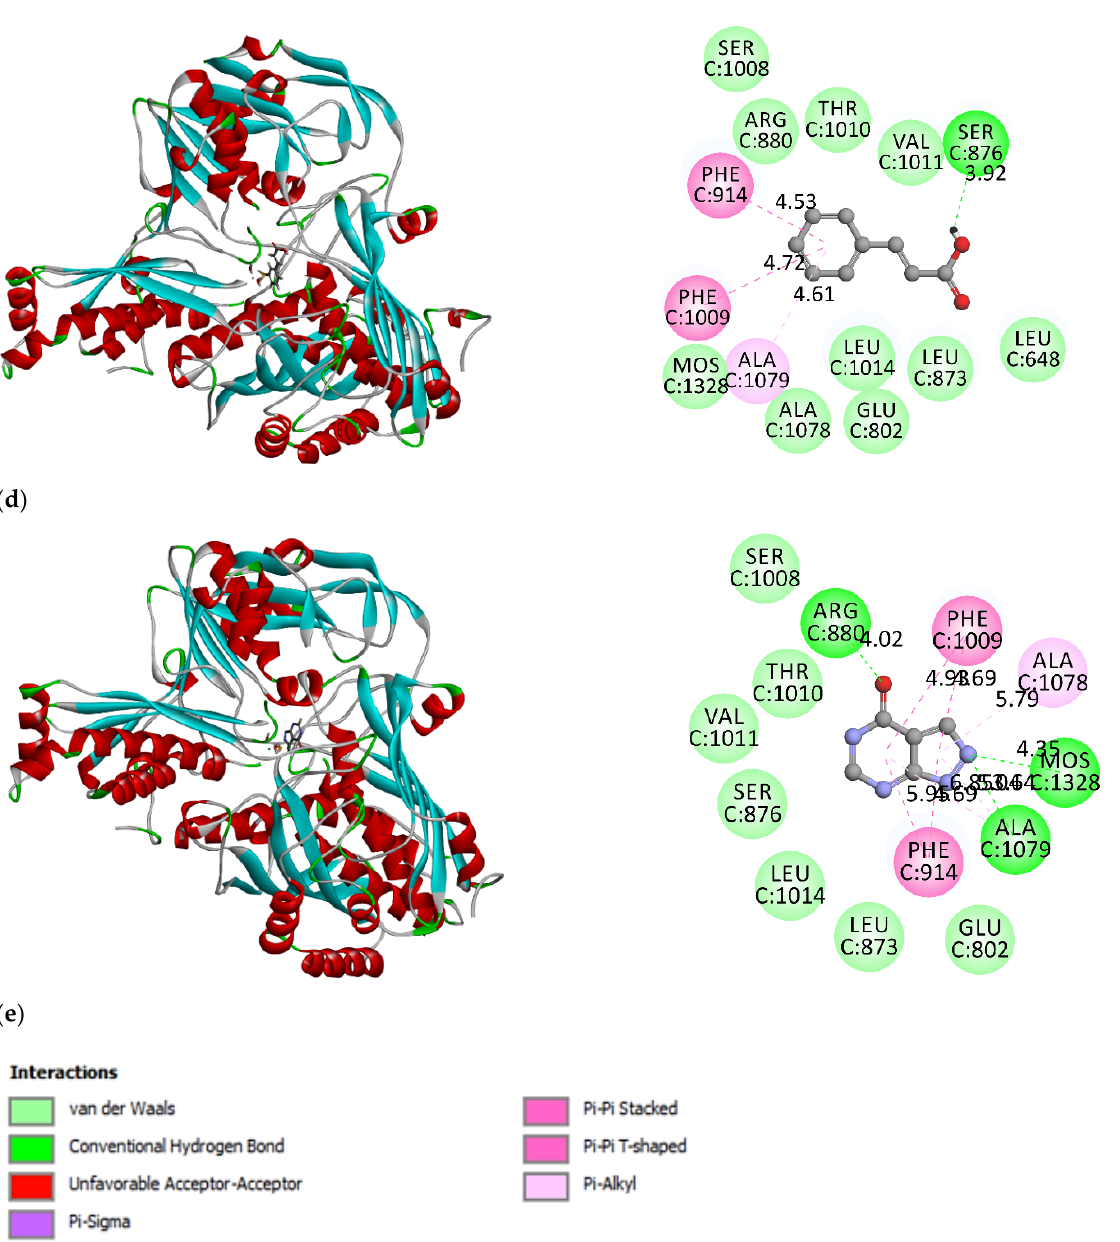
Figure 2. The interactions between ( a ) kaempferol, ( b ) apigenin, ( c ) homovanillic acid, ( d ) trans - cinnamic acid, ( e ) allopurinol, and XO residues from molecular docking.